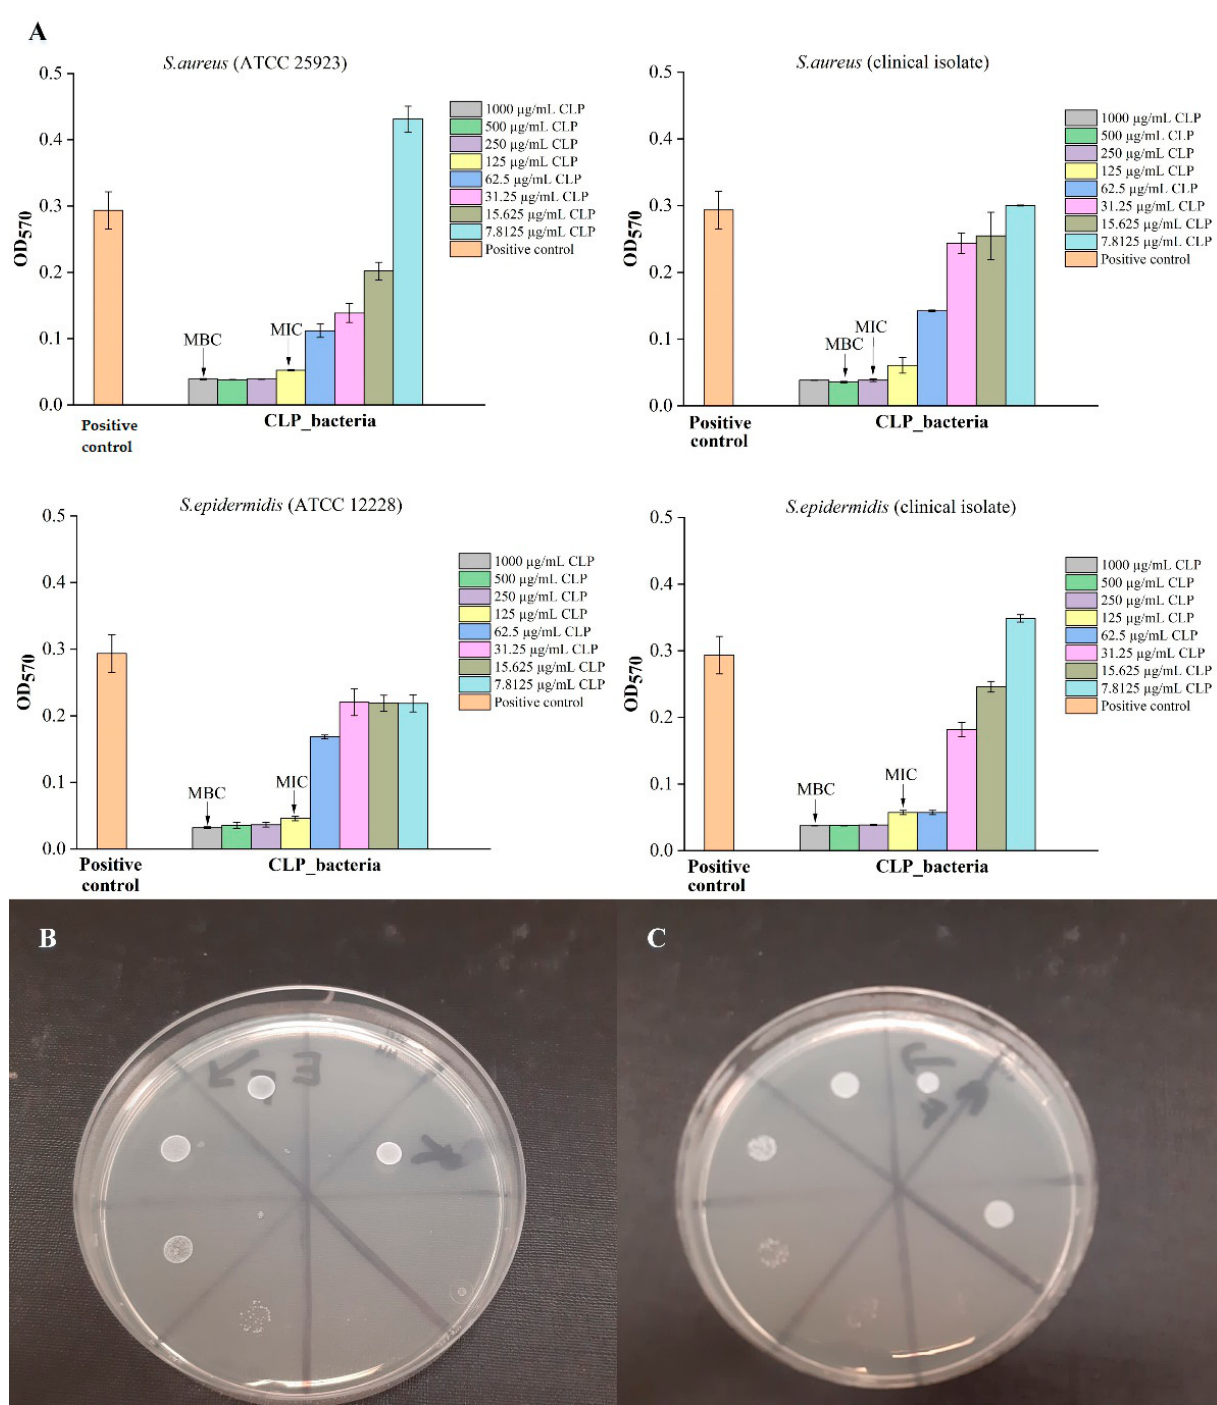
Figure 5. Antibacterial properties of different CLP solutions at various concentrations: ( A ) detected MIC and MBC concentrations for 4 bacteria ( S. aureus (ATCC 25923), S. epidermidis (ATCC 12228), S. aureus (clinical isolate), S. epidermidis (clinical isolate); ( B ) MBC test for S. aureus (clinical isolate); ( C ) MBC test for S. aureus (ATCC 25923). The diameter of the Petri dishes is 8.5 cm. As shown in Figure 5, the MIC and MBC values for pure CLP solution were first determined to test the ability of the substance to provide an antibacterial effect against selected bacterial cultures. The data showed that against S. aureus (ATCC 25923), S. epider- midis (ATCC 12228) and S. epidermidis (clinical isolate), higher CLP concentrations (1000